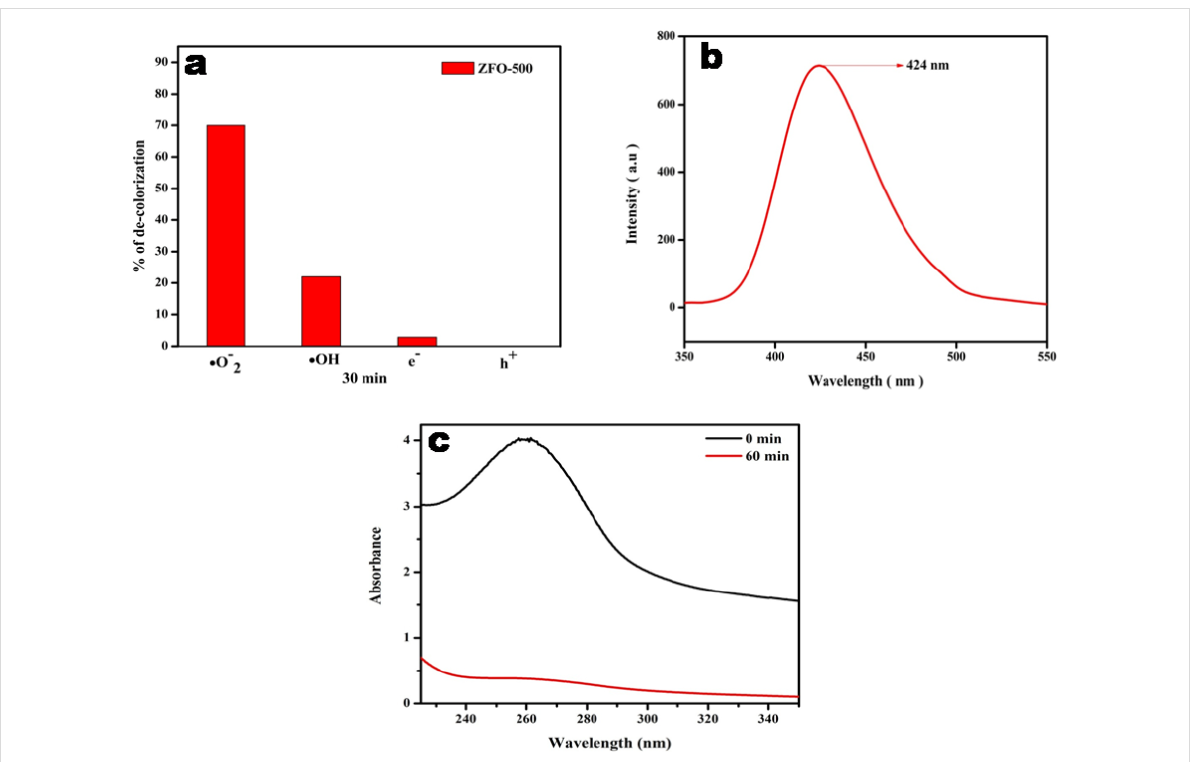
Figure 11: (a) Histogram representing the role of active species in the decolourization of Congo Red; (b) fluorescence spectra of ZFO-500 solution with TA; (c) absorbance spectra of nitroblue tetrazolium solution with ZFO-500 before and after